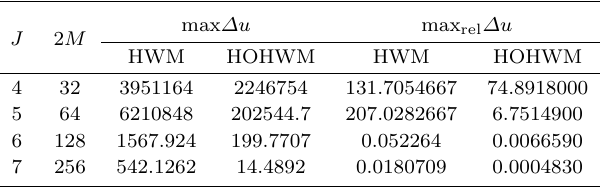
Results for the KdV equation soliton interaction: maximal deviation of the numerical solution from the exact solution max ∆u and maximal relative deviation max rel ∆u against the resolution parameter J with initial conditions (5.4) and boundary conditions (4.11) ( α = 1, c B = 10000, x 0 B = 1 / 5, c S = 10000 / 3, x 0 S = 2 / 5, x ∈ [0 , 1], t ∈ [0 , 0 . 6 × 10 − 4